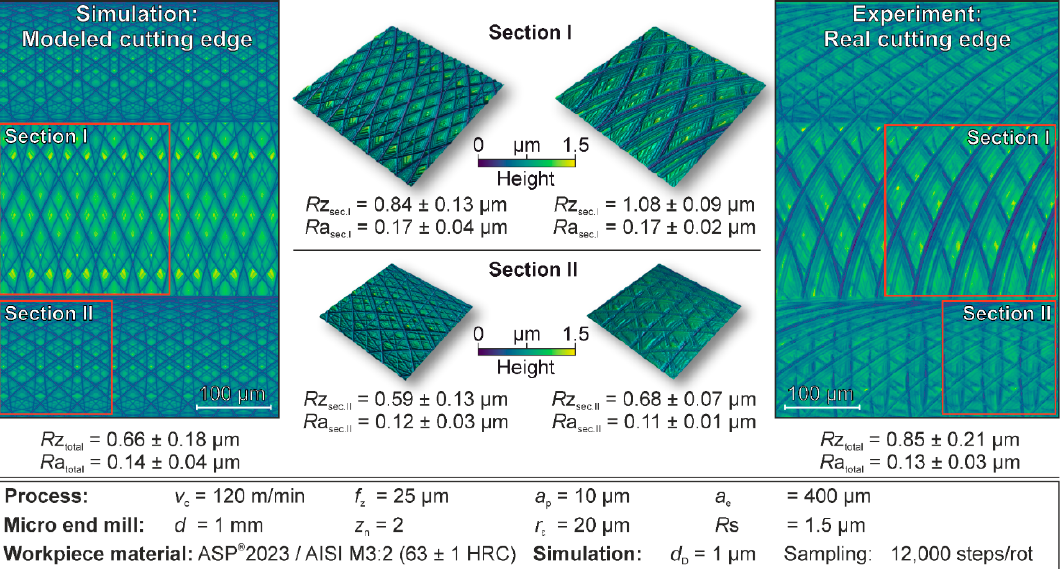
Figure 15. Influence of lateral overlapping on surface topography.